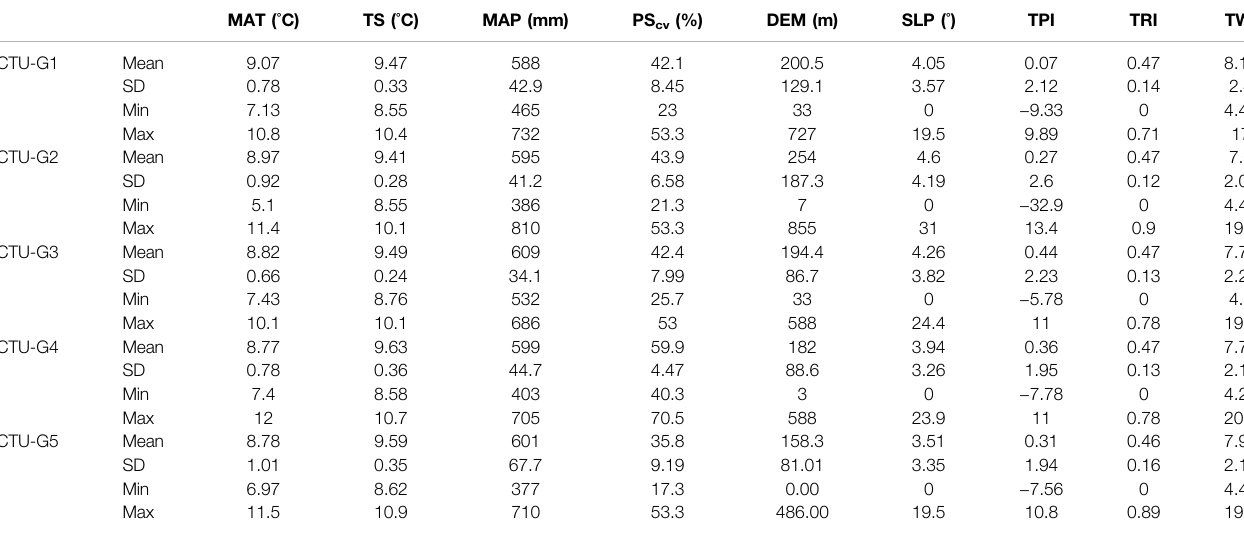
TABLE 4 | Summary statistics of the reconstructed environmental variables for the CTU